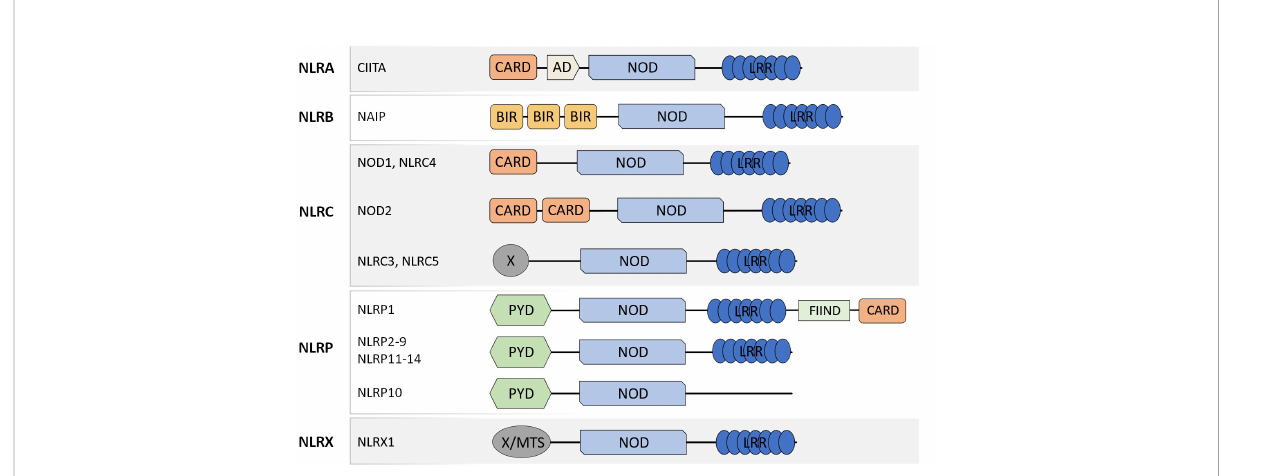
FIGURE 1 Schematic representation of molecular domain structures of the different NLR subfamilies. NLR present a common domain structure with an N- terminal effector domain, a central NOD domain, and a C-terminal LRR domain. The different effector domains allow the categorization of NLR into fi ve subfamilies: NLRA, NLRB, NLRC, NLRP, and NLRX. CARD caspase recruitment domain, AD acidic transactivation domain, NOD nucleotide-binding oligomerization domain, LRR leucine-rich repeat, PYD pyrin domain, FIIND function to fi nd domain, X unidenti fi